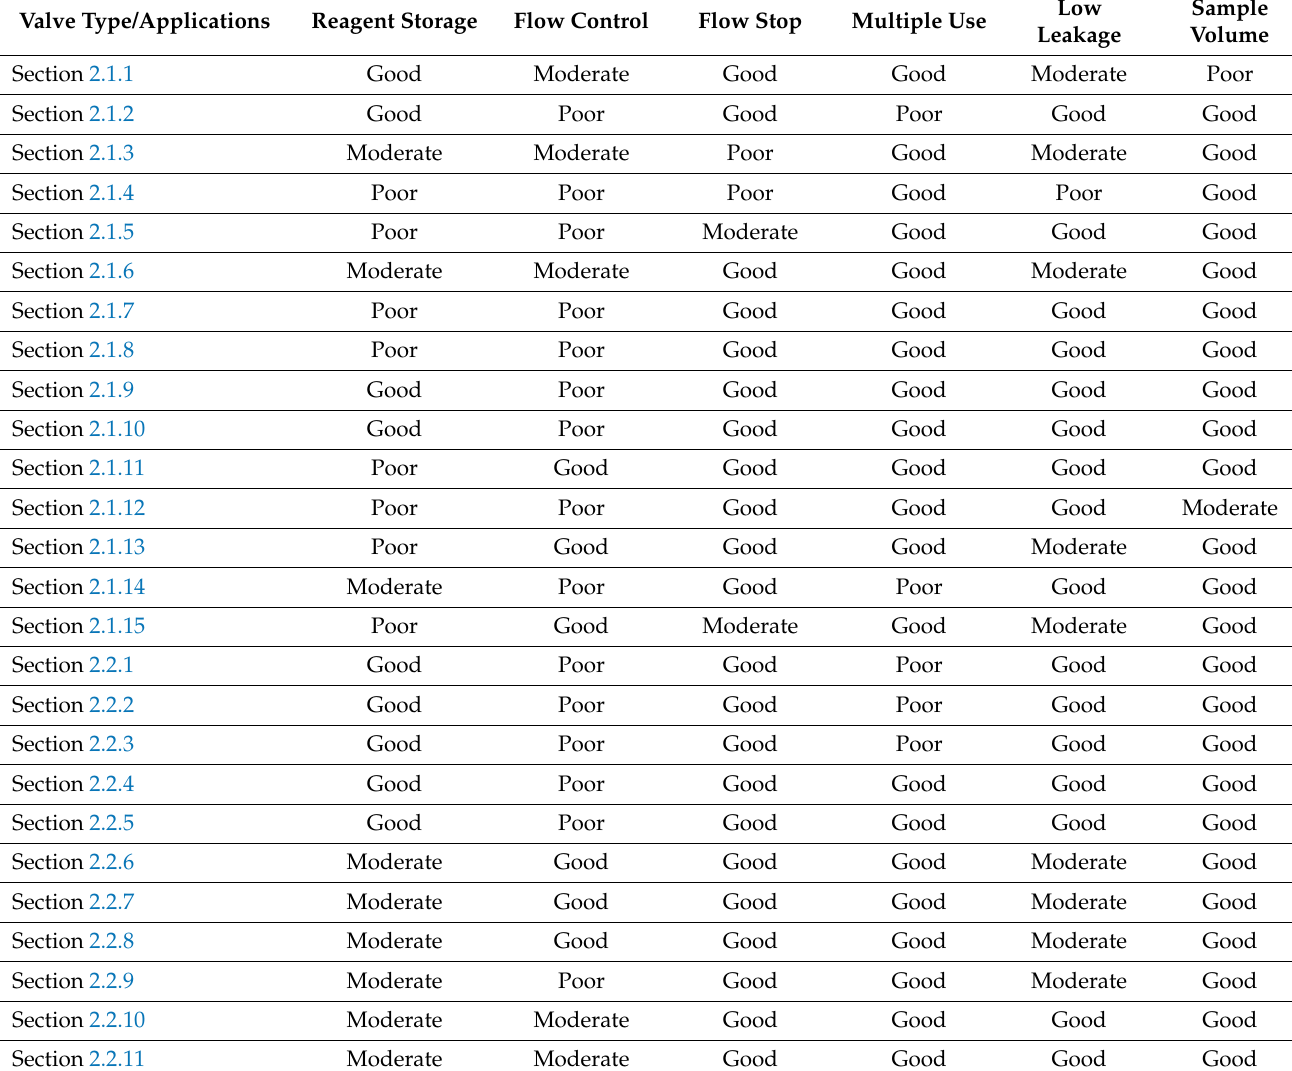
Table 2. Classification of valves based on their fit for specialized